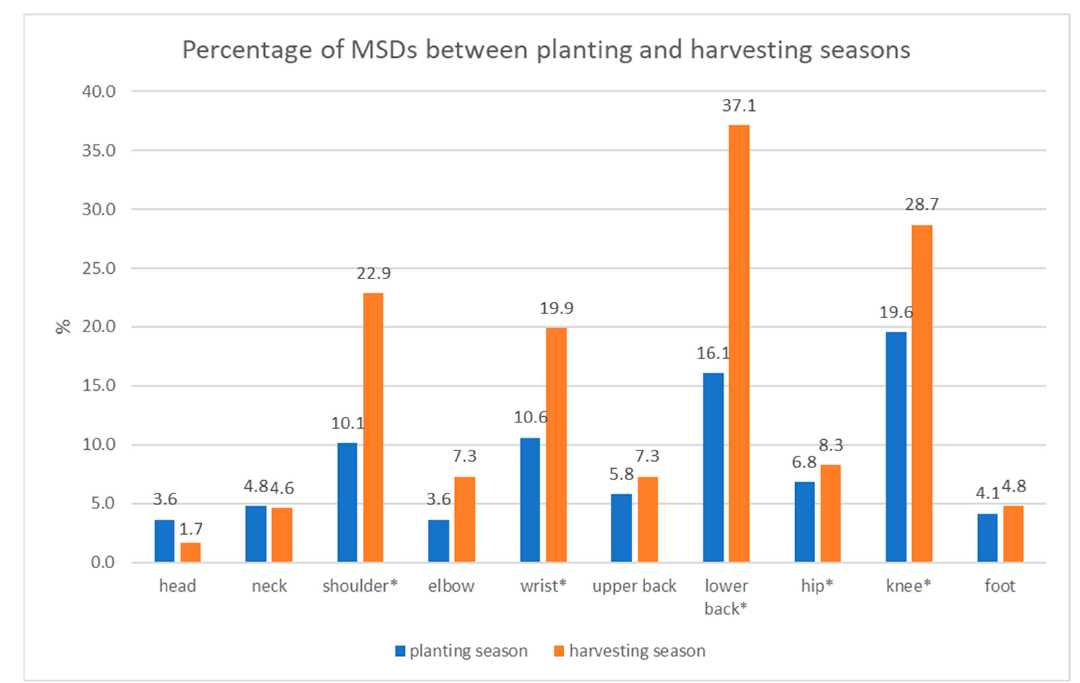
Figure 3. The percentage of MSDs between the planting and harvesting seasons. * = statistically significant difference ( p < 0.05).